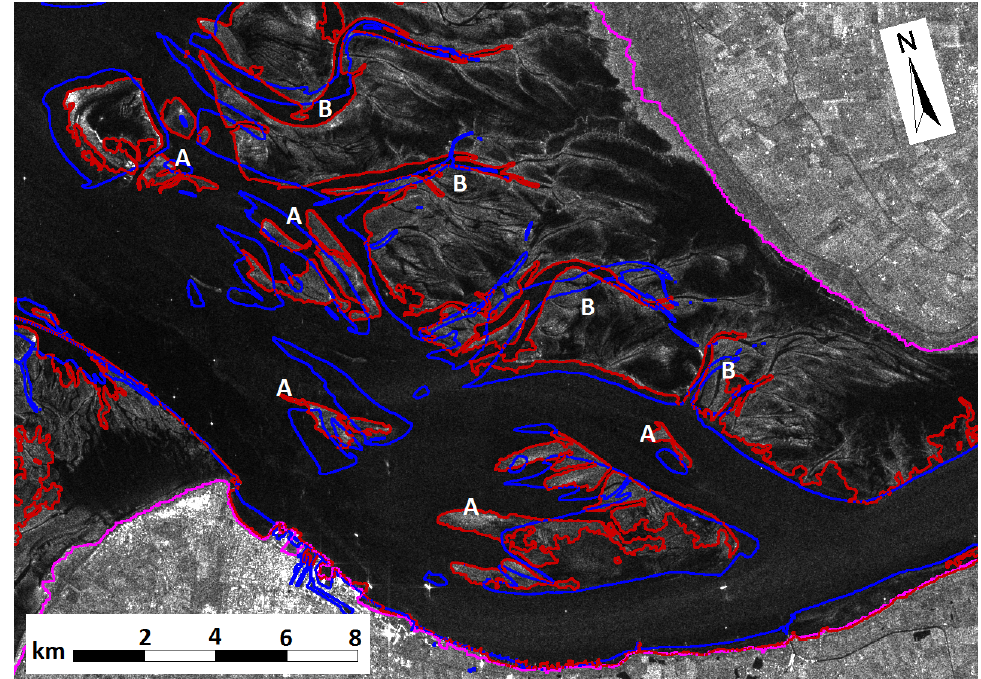
Figure 3: Sub-scene of a Sentinel-1 IW scene of the Elbe estuary, acquisition parameters are given in Table 1. The red lines indicate the boundaries found by our algorithm, the blue lines indicate the Lowest Astronomical Tide (LAT) level according to the bathymetry data and the magenta lines show the SWBD coastline. The letters indicate selected differences to the bathymetry data for shifted sand banks (A) and tidal inlets